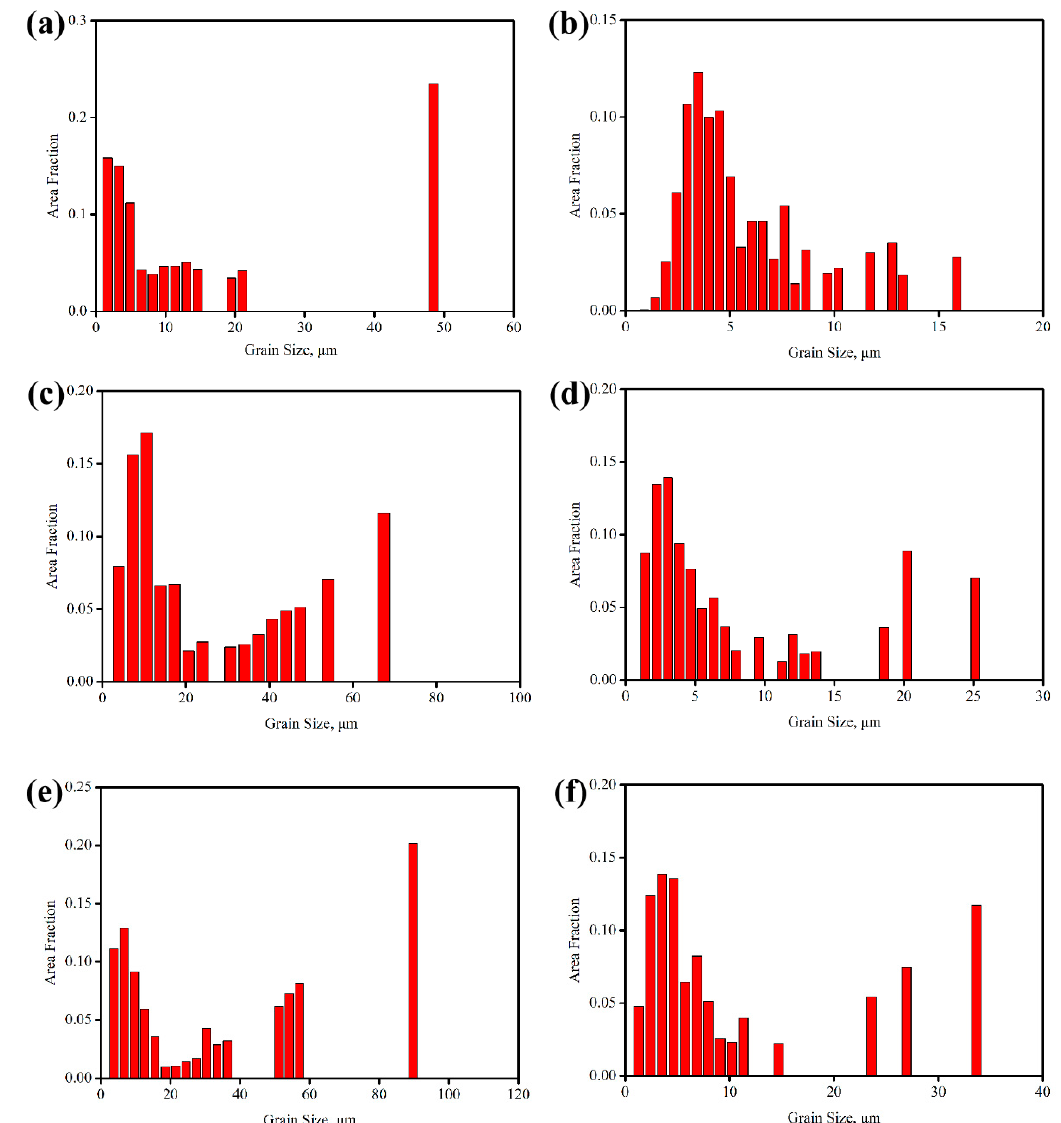
Figure 3. ( a ) IPF mapping, discrete plot and texture of alloy extruded at 800 °C; ( b ) IPF mapping, discrete plot and texture along extrusion direction (ED) of composite extruded at 800 °C; ( c ) highlighted mapping of ( a , b ); ( d ) grain orientation spread (GOS) mapping of ( c ).